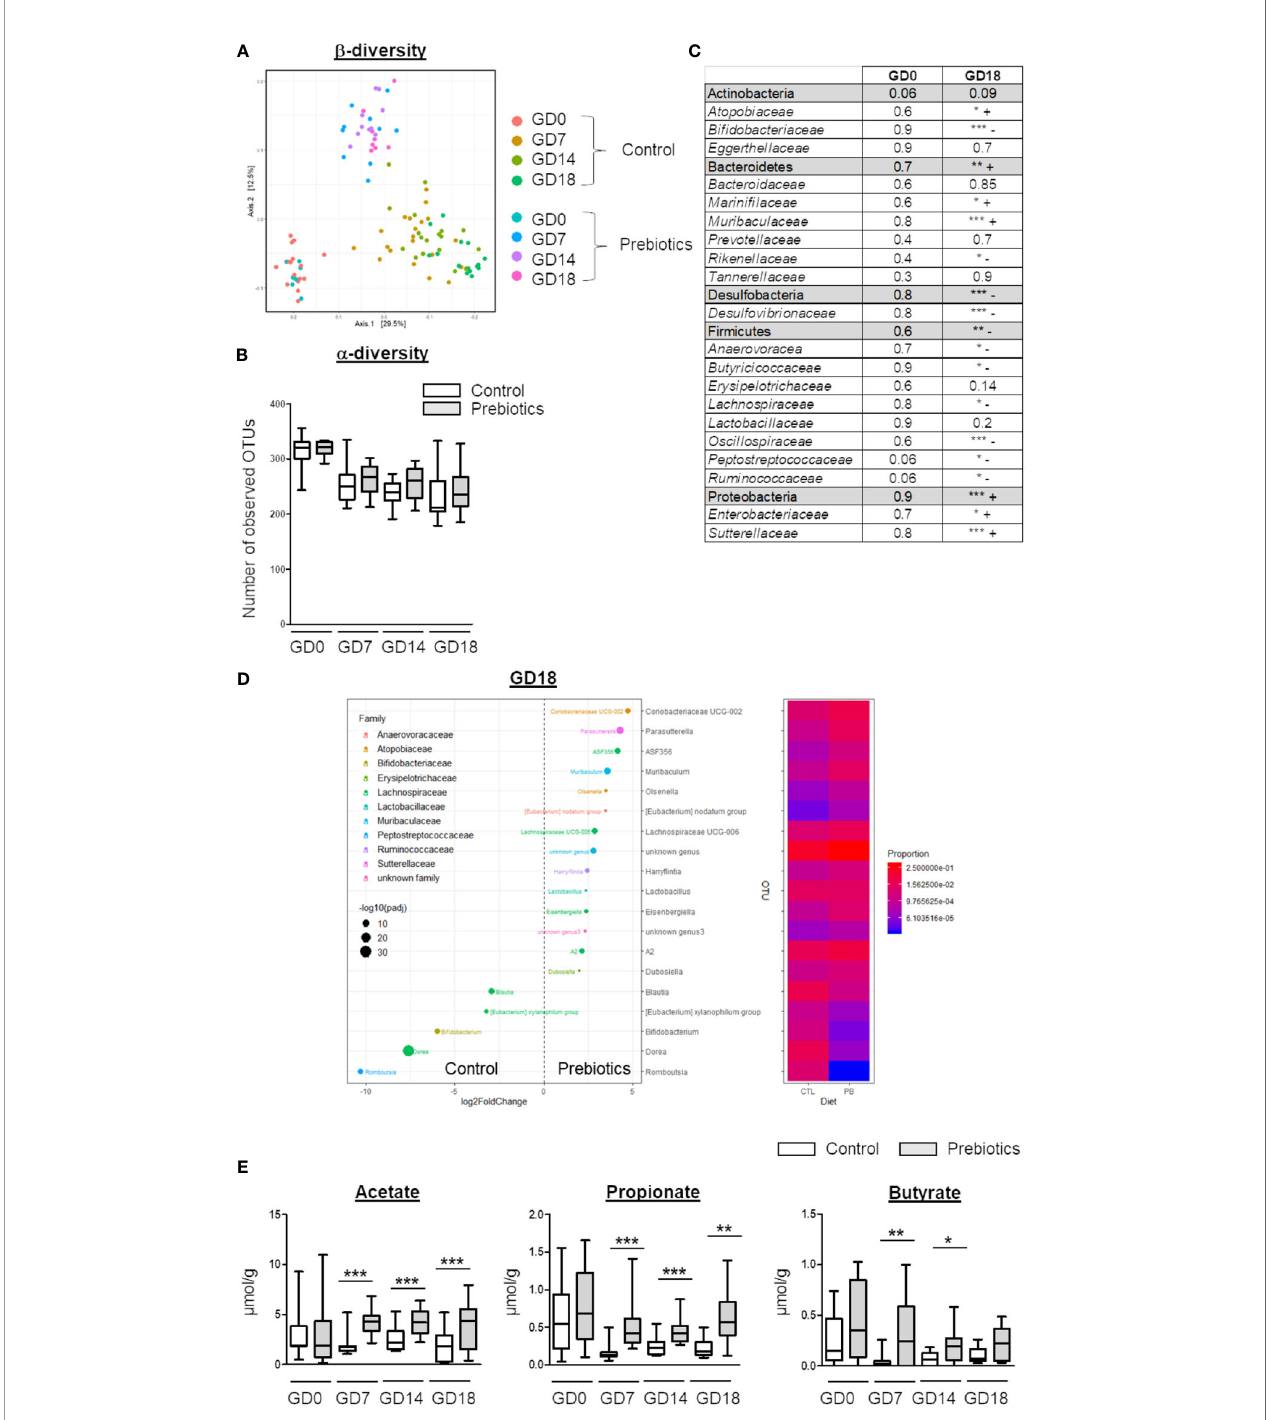
FIGURE 2 | Effects of GOS/inulin supplementation during pregnancy on the fecal microbiota composition and SCFA levels. (A) Analysis of b -diversity by unweighted UniFrac-based PCoA of stools from dams fed a control or prebiotic diet before gestation (GD0) and at 7, 14 and 18 gestational days (GD7, GD14 and GD18, respectively). (B) a -Diversity of stools from dams fed a control (white) or prebiotic diet (gray) on GD0, GD7, GD14 and GD18. (C) Table summarizing the relative abundance of phyla and families in the fecal microbiota. “ + ” indicates an increase and “ - ” indicates a decrease in the prebiotic group compared to the control group (*=p<0.05, ** = p<0.01, *** = p<0.001). (D) Graphical representation and heatmap of sex variance in stools from dams fed a control or prebiotic diet at GD18. (E) Evaluation of SCFA (acetate, propionate, and butyrate) levels in stools from dams fed a control (white) or prebiotic diet (gray) on GD0, GD7, GD14 and GD18 (** = p<0.01, *** =